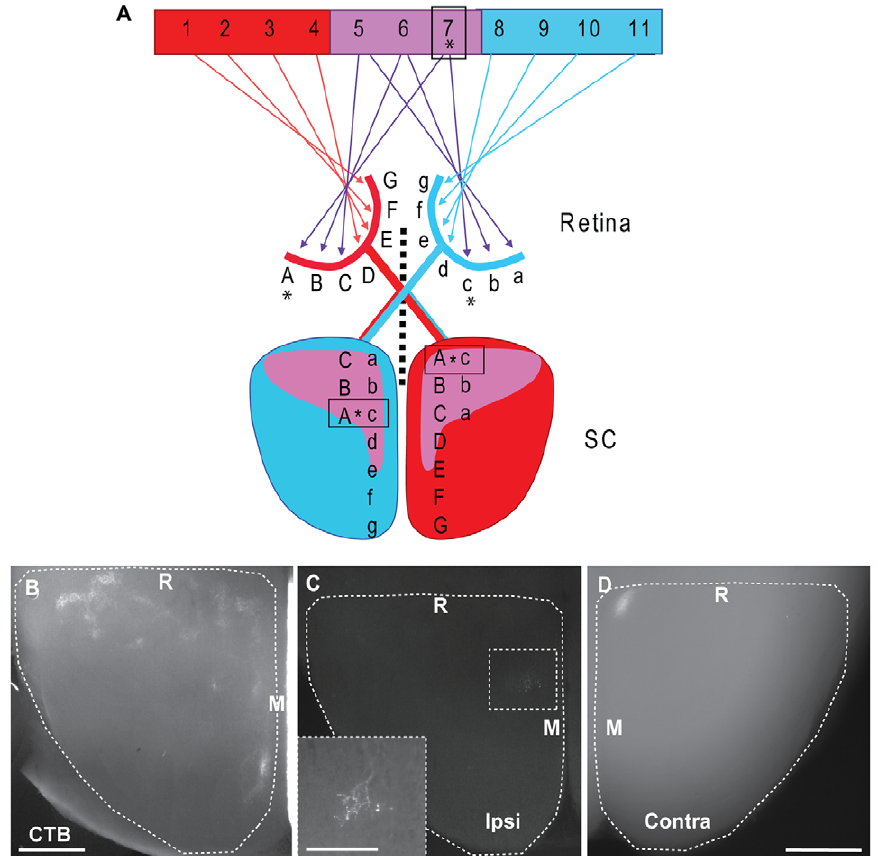
Figure 1. Schematic diagram and DiI tracing illustrating the visuotopic organisation of the retinocollicular pathway from ventrotemporal retina in the mature mouse. A: Left eye (red) G-A, representing visual field 1–7 projects topographically to the contralateral SC (red). Similarly, the right eye (blue) a–g, represents visual field 5–11 which projects topographically to the left SC (blue). The binocular field (centre, purple) 5–7 is represented by the ventrotemporal retina of both eyes (C-A, red & a–c, blue) and is the origin of the ipsilateral projection. The ipsilateral projection maps in reverse retinotopic order to produce an aligned map in the SC. Note that a given point in the visual field (e.g. 7,*) falls on different locations in the two retinas (red A & blue c, *). In order to generate an aligned map, these different retinotopic locations must project to the same region in the target (boxed regions, *). Conversely, the same retinotopic locations (red A & blue a) map to two different locations in the SC. When considering the ipsilateral and contralateral projections arising from a given retinotopic location from a single eye (e.g. red A, *), these will project to distinct regions in the contralateral and ipsilateral SC. Note the differing positions of the representation of red A in each collicular hemisphere (boxes, *). B: Horizontal section, approximately 300 m m below the surface of a flattened SC, from a P28 mouse following an injection of CTB into the ipsilateral eye to label all RGC axons. Ipsilateral terminals are arranged in clusters in the rostromedial region of the SC. The majority of the ipsilateral projection is visible in this single section. C–D: Horizontal section through the ipsilateral (ipsi) SC (C) and a whole-mount preparation of the contralateral (contra) SC (D) following a focal injection of DiI into the VTC from a P28 mouse. A dense contralateral TZ is visible at the rostromedial corner of the SC in D. In the ipsilateral SC (C) the TZ is offset caudolaterally from the contralateral TZ. The ipsilateral TZ is much less dense than the corresponding contralateral TZ and is shown at higher power in the inset. Scale bars: 500 m m. Scale in D also applies to C. Scale in inset in B: 200 m m. R: Rostral, M: Medial. Dashed lines delineate the borders of the